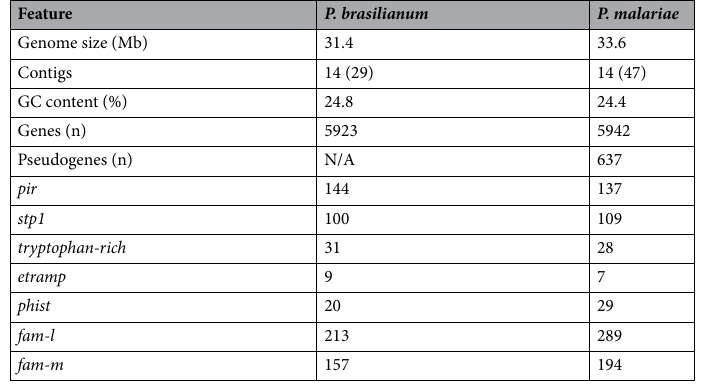
Table 1. Assembly and annotation summary for P. brasilianum and P. malariae. The genome size, number of chromosomes (scaffolds), GC content, and number of genes and pseudogenes is listed for P. brasilianum and P. malariae . The final 7 rows list the number of genes in P. malariae whose gene ID is annotated as either pir, stp1, tryptophan-rich, etramp, phist, fam-l, or fam-m . These do not include pseudogene annotations. Corresponding values were determined for P. brasilianum through matching annotations obtained by